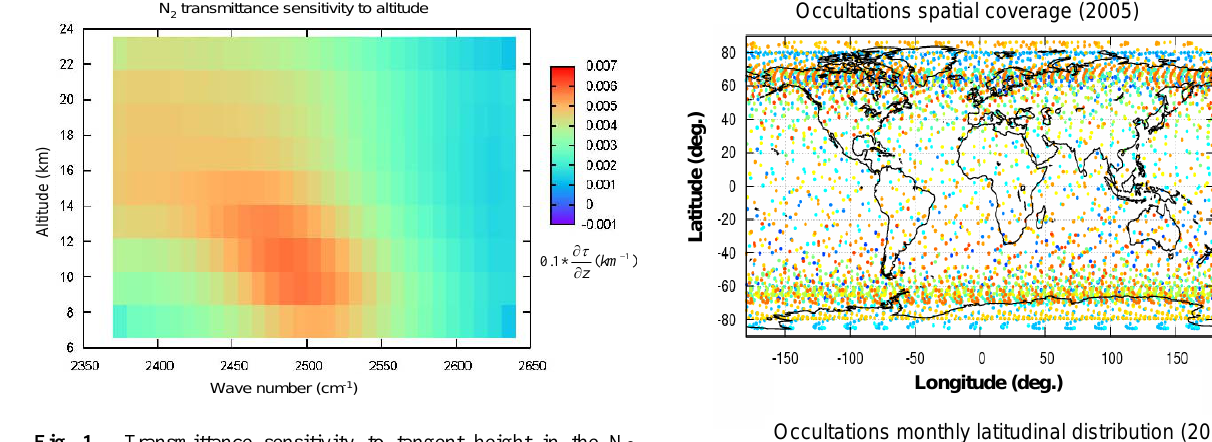
Fig. 1. Transmittance sensitivity to tangent height in the N 2 collision-induced absorption (2370–2640cm − 1 ) spectral range. The color bar values represent the transmission variation due to a 100m tangent height change.